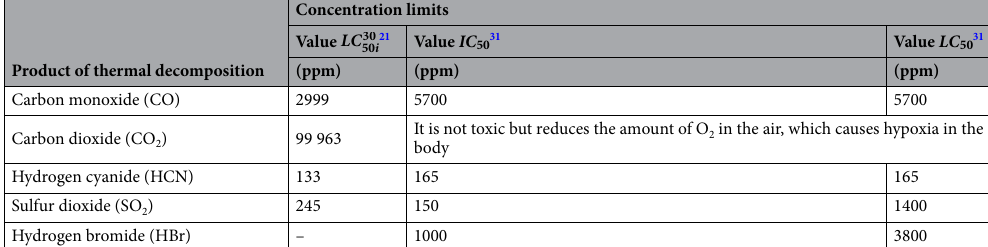
Table 3. Concentration limits of the thermal decomposition products 21,31 .